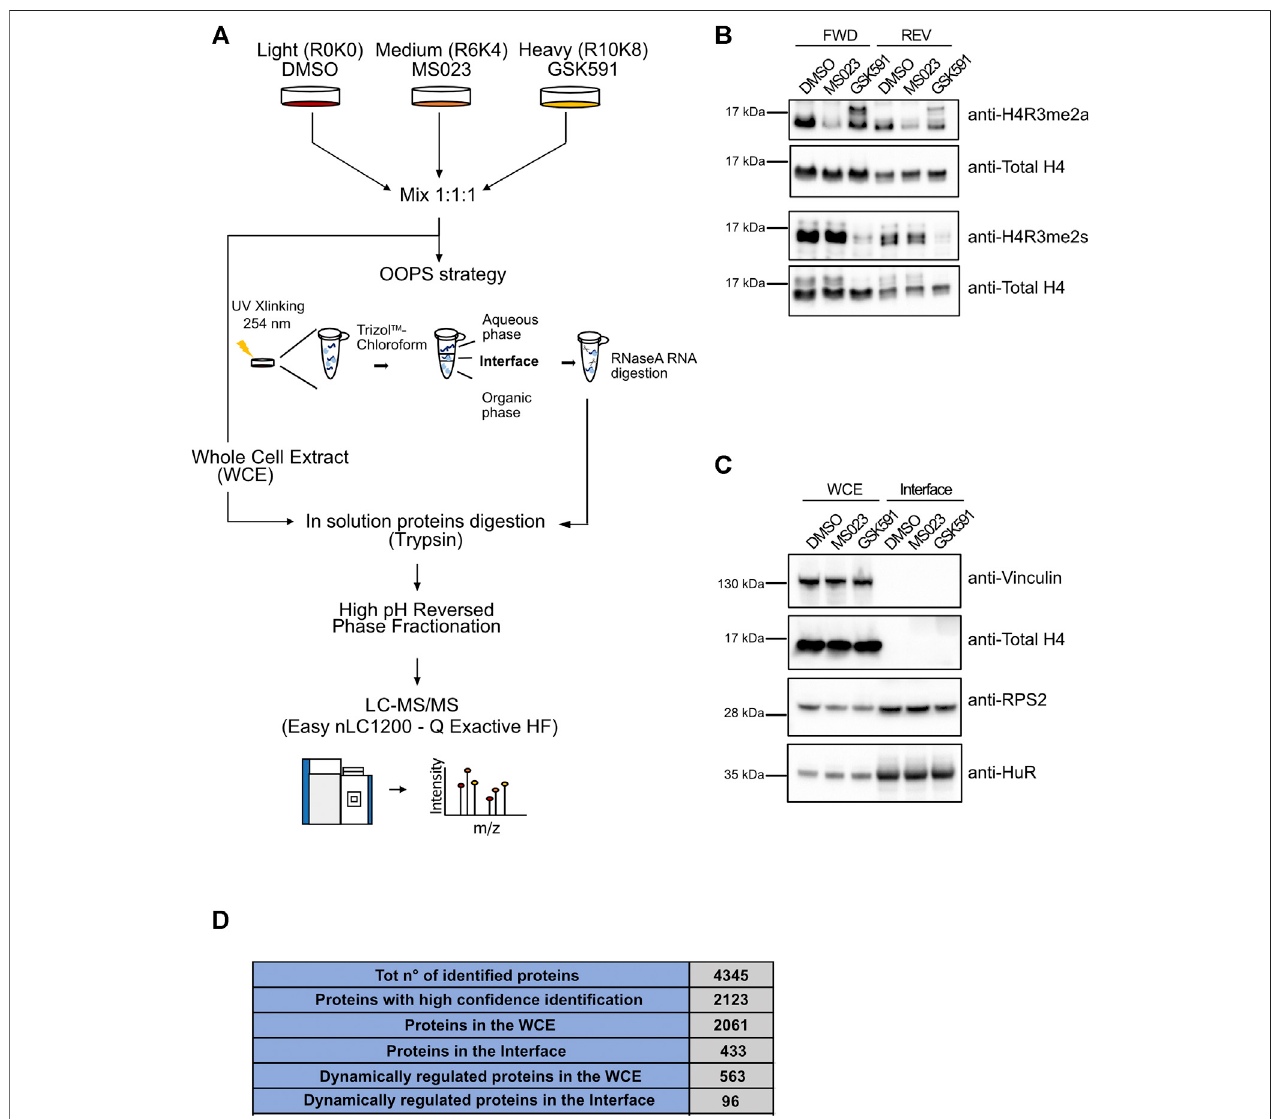
FIGURE 1 | Setup of the proteomic approach for the systematic analysis of RNA-protein interactions: the OOPS strategy in combination with PRMT pharmacological inhibition and triple SILAC labelling. (A) Representative work fl ow of the proteomic approach. Cells were grown in light (R0K0), medium (R6K4) and heavy(R10K8)SILACmediumandtreatedwithDMSO,10 µMMS023and5 µMGSK591for48h.Aliquotsfromthelight-,medium-andheavy-labelledcellsweremixed in 1:1:1 proportion and saved as whole cell extract (WCE), while the remaining cells were UV-crosslinked at 254 nm and phase-partitioned through a Trizol ™ - chloroform mixture, as described in (Queiroz et al., 2019). Proteins extracted from the WCE and from the interface fraction were subjected to in-solution digestion with Trypsin and fractionation by off-line HpH-RP chromatography. Tryptic peptides were analyzed by high resolution LC-MS/MS. (B) Western Blot (WB) validation of the PRMTpharmacologicalinhibition.Beforemixingin1:1:1proportiondescribedin (A) ,analiquotofeachconditionwasusedtotestthemethylationstateofdistincthistone Rresiduesspeci fi callytargeted byPRMT1andPRMT5byWB,bothintheforward(FWD)andinthereversed(REV)experiment. Reductionofasymmetricdi-methylation of arginine 3on histone 4 (H4R3me2a) was observed upon MS023 treatment; total unmodi fi ed H4 was used as loading control. Similarly, the reduction of symmetric di- methylation of arginine 3 on histone 4 (H4R3me2s) was observed upon GSK591 treatment (H4 was used as loading control). (C) WB validation of RBPs enrichment by OOPS.WBanalysisoftheRNAbindingproteinsRPS2andHuRcon fi rmstheirenrichmentintheinterfacefractionuponOOPS,whiletheabsenceofthenon-RBPprotein Vinculinand Histone4fromthesamefraction wasusedtoassesstheselectivityofthemethod. (D) SummaryoftheMS-identi fi edproteinsbyOOPS.Tablesummarizing thenumberofproteinsidenti fi edbyMaxQuantfromrawMSdata,aftertheapplicationoftheindicated fi lteringcriteria:1)totalnumberofidenti fi edproteins,uponremoval of reverse hits and contaminants; 2) total number of proteins with Andromeda score ≥ 25 and at least two peptides, one of which unique, for each experiment (high- con fi dence identi fi cation); 3) total number of proteins identi fi ed with high con fi dence in the WCE; 4) total number of proteins identi fi ed at high con fi dence in the interface fraction from OOPS; 5) number of proteins dynamically regulated by the drugs in the WCE; 6) number of proteins dynamically regulated by the drugs in the interface fraction from OOPS.